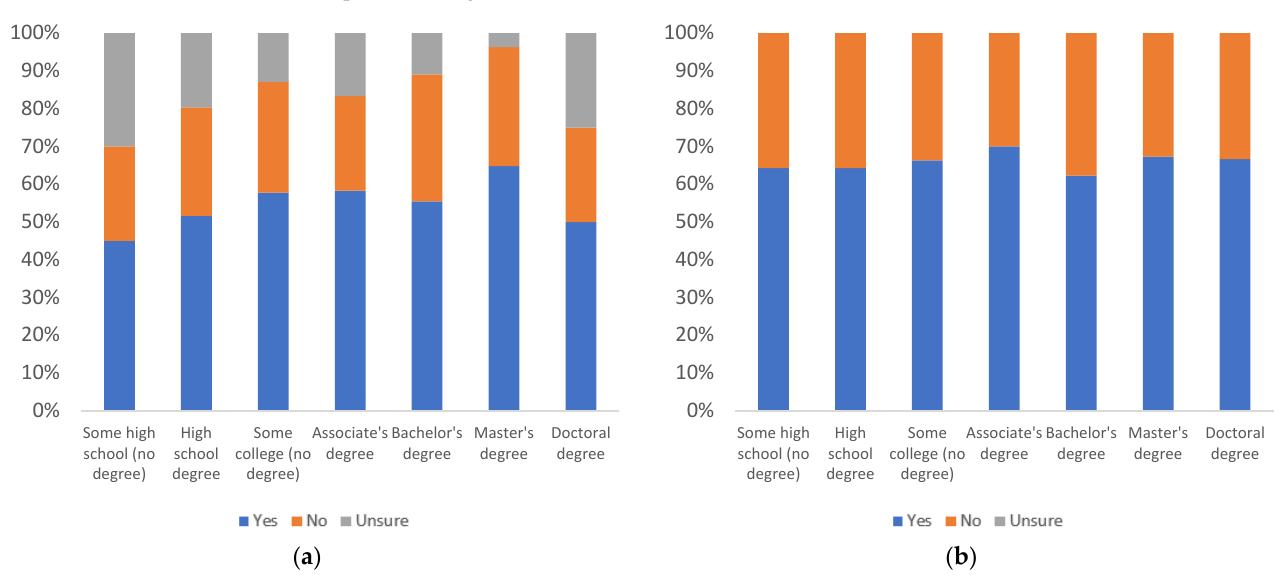
Figure 28. Label use, by education level: ( a ) with uncertain respondents (left) and ( b ) without uncertain respondents (right).